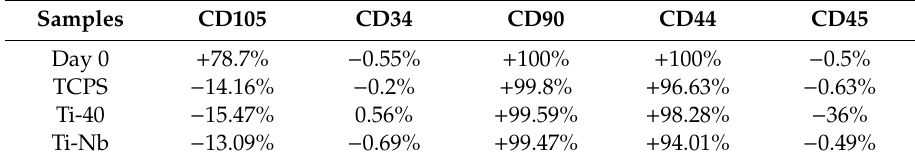
Table 2. Phenotyping of fibroblasts grown on different substrates. TCPS: tissue culture polystyrene.